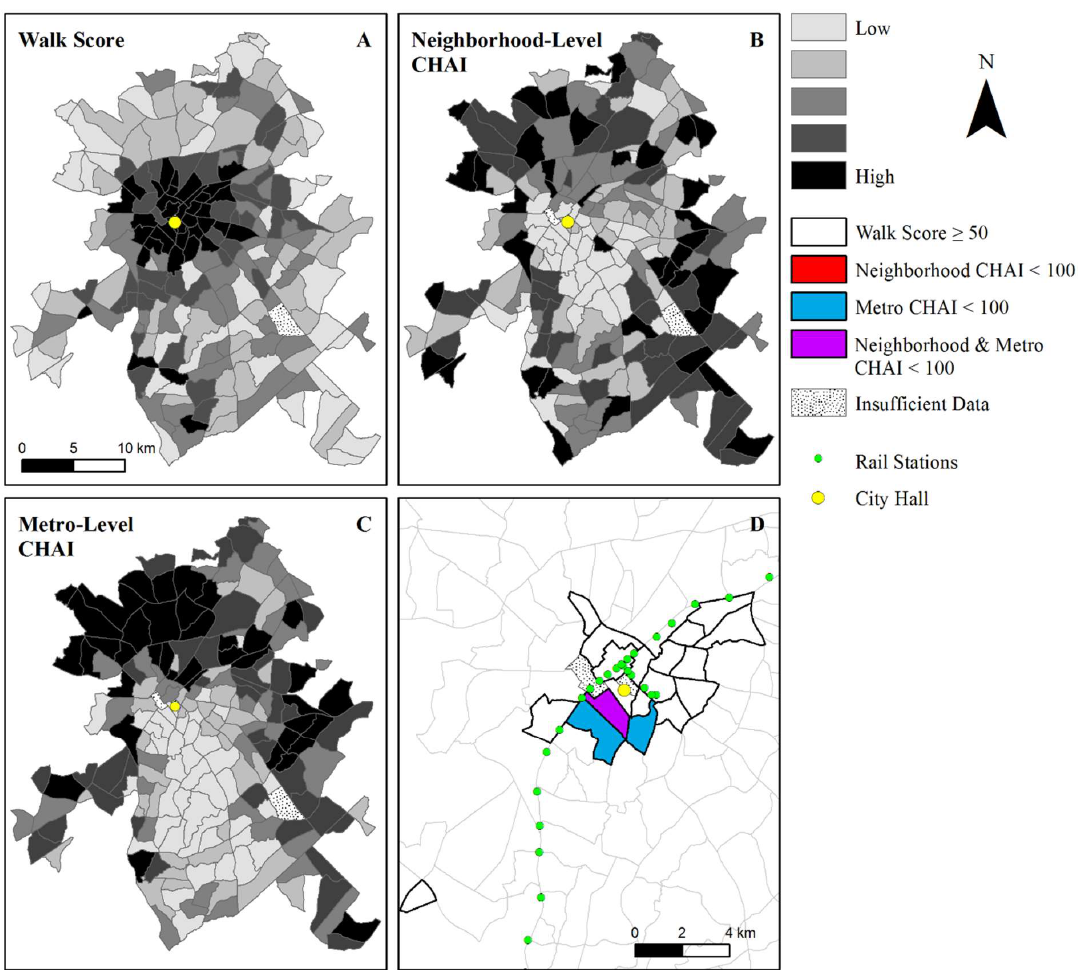
Figure 1. The spatial relationship between ( A ) walkability and housing affordability calculated at the ( B ) neighborhood and ( C ) metropolitan scale for census tracts within the urbanized area of Charlotte, NC. Of particular interest is where ( D ) relatively high walkability and low housing affordability overlap. The comprehensive housing affordability index (CHAI) was calculated by summing the standardized housing affordability for home owners and renters, and weighing each based on their proportion within each census tract.